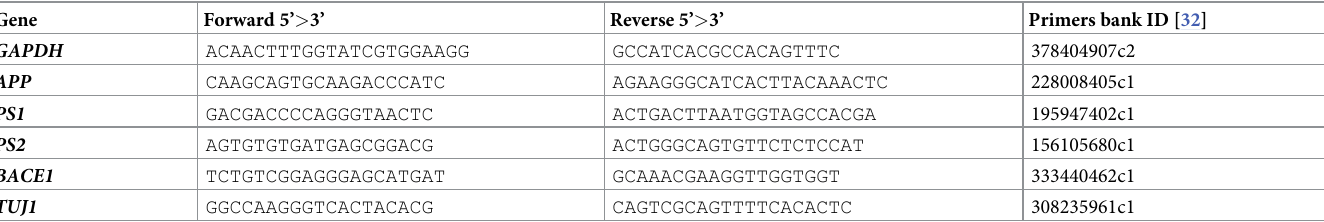
Table 1. The list of primers used in this